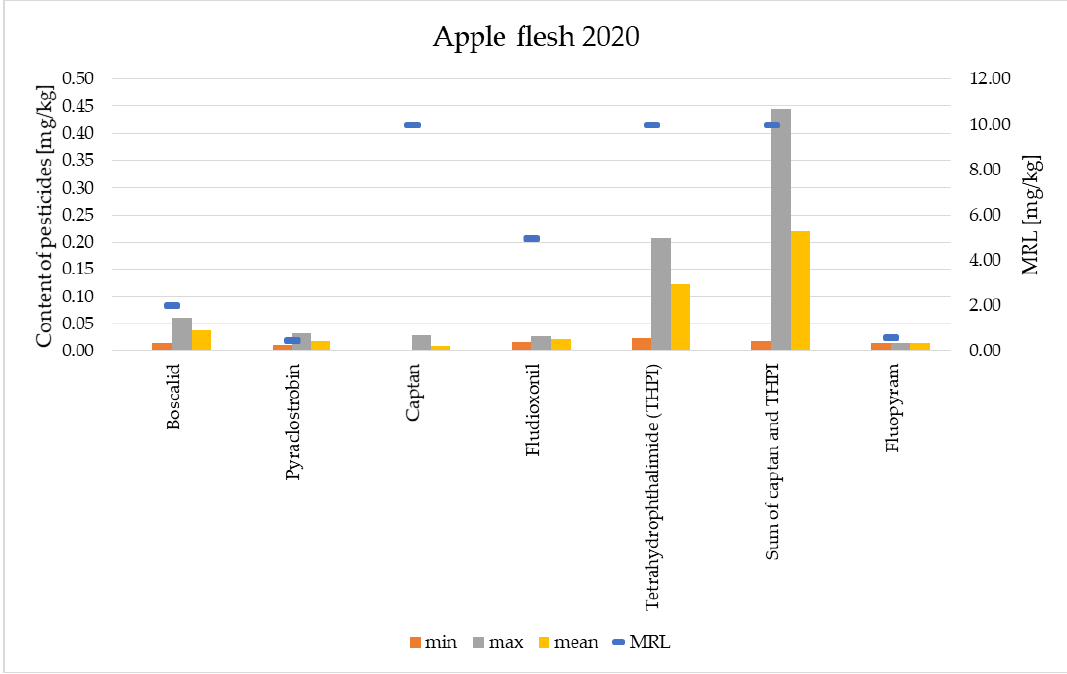
Figure 9. Content of pesticides in samples of flesh of apples from the harvest of 2012.